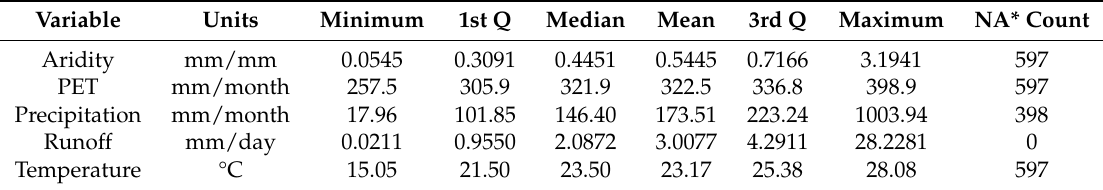
Table 1. Descriptive Statistics for all variables included in the study.